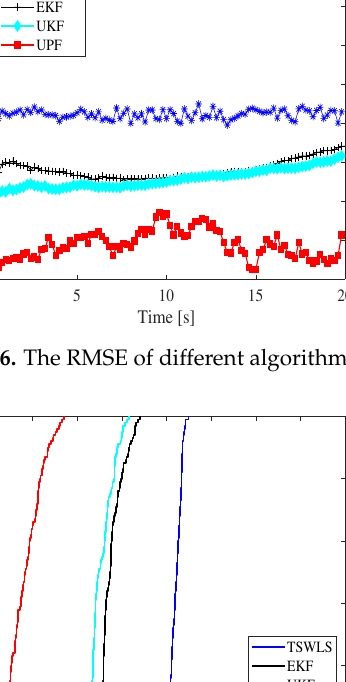
Figure 7. The CDF of RMSE for different algorithms in NLOS scenario ( σ θ